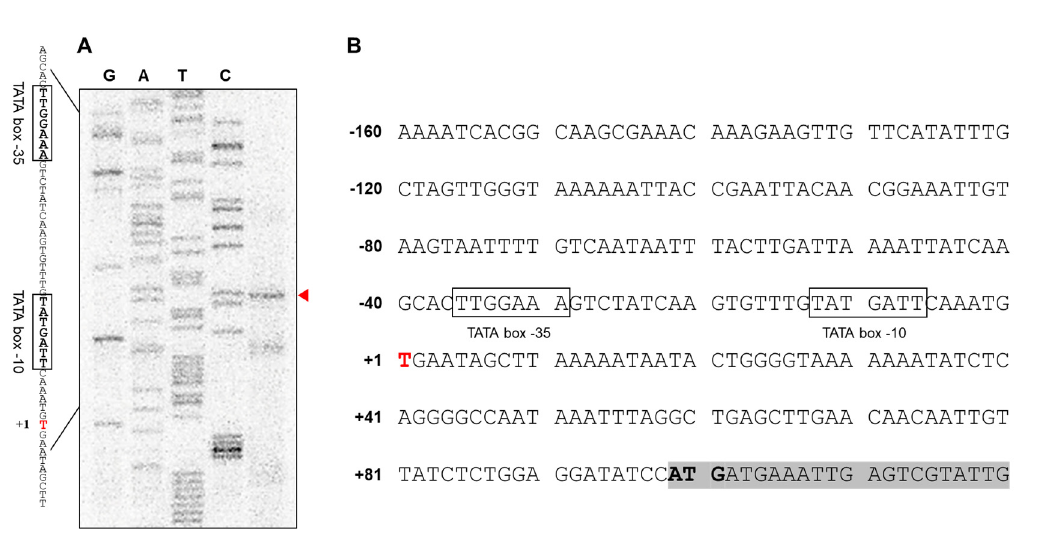
Figure 1. The results of the primer extension assay indicate the location of the transcriptional start site (TSS) of AbOmpA ( A, B ). To identify the TSS of Acinetobacter baumannii OmpA , we performed a primer extension assay. The TSS was located at position –89 from the start codon. Putative -35 and -10 region are marked in open